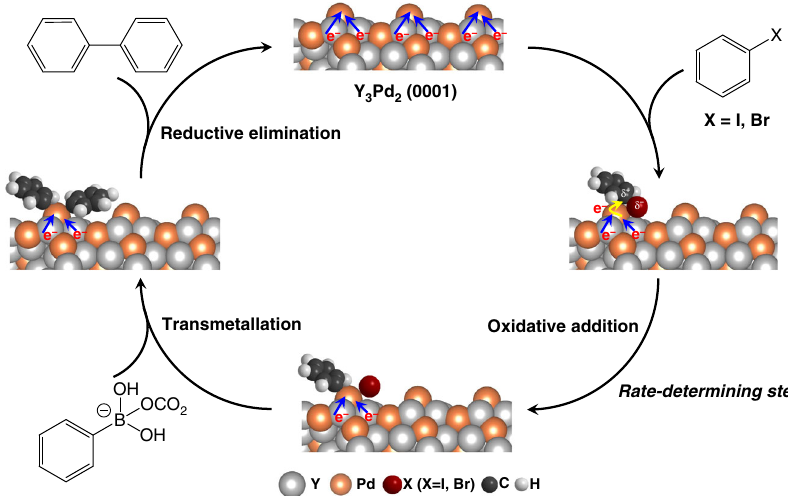
Fig. 4 Proposed mechanism. Proposed reaction paths for the Suzuki cross-coupling process over Y 3 Pd 2